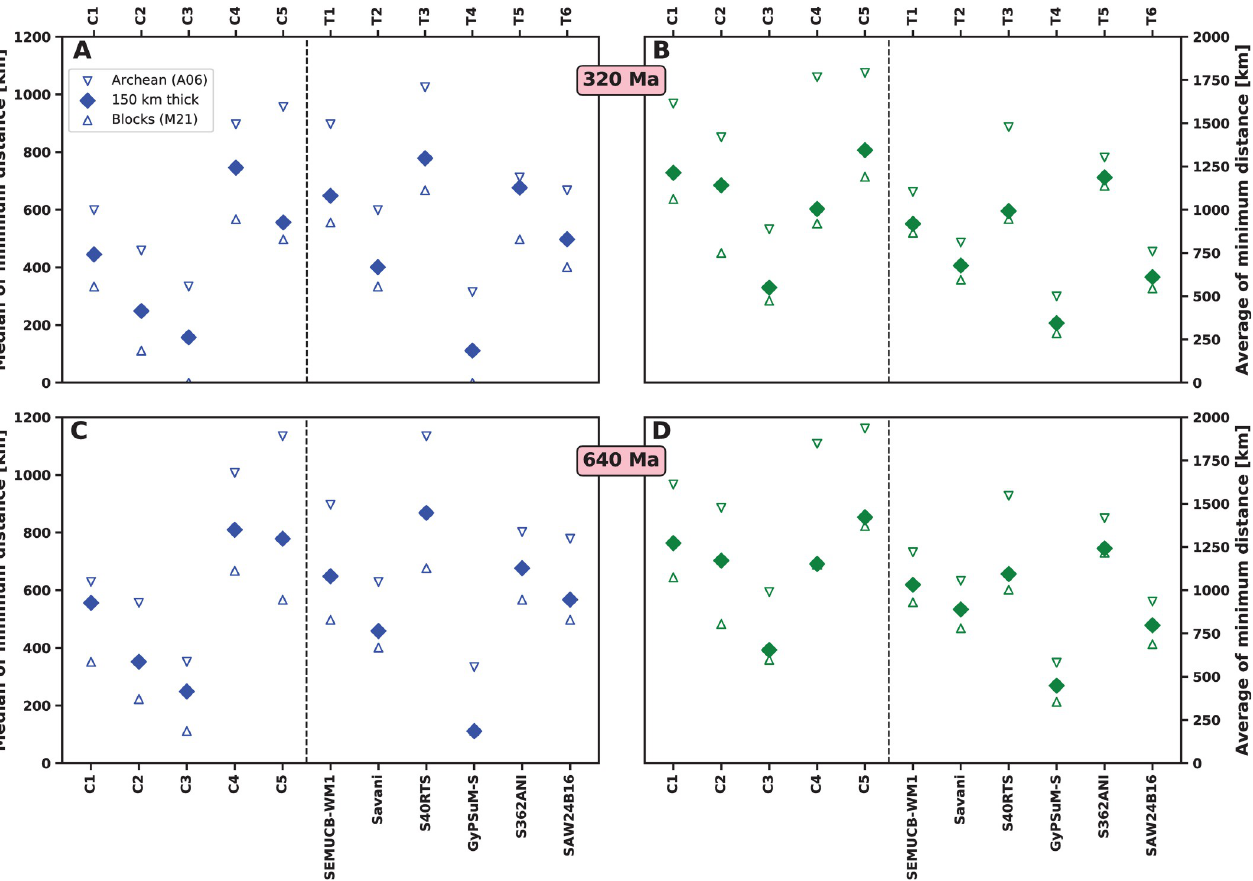
Fig 12. Results for different lithospheric extents and reconstruction M21NNR. Same as Fig 11 but for tectonothermal ages greater than 2.5 Ga from ref. [46] (open downward pointing triangles, “Archean (A06)”), lithosphere thicker than 150 km [5] (diamonds, “150 km thick”) and tectonic blocks from ref. [38] (open upward pointing triangles, “Blocks (M21)”), using reconstruction